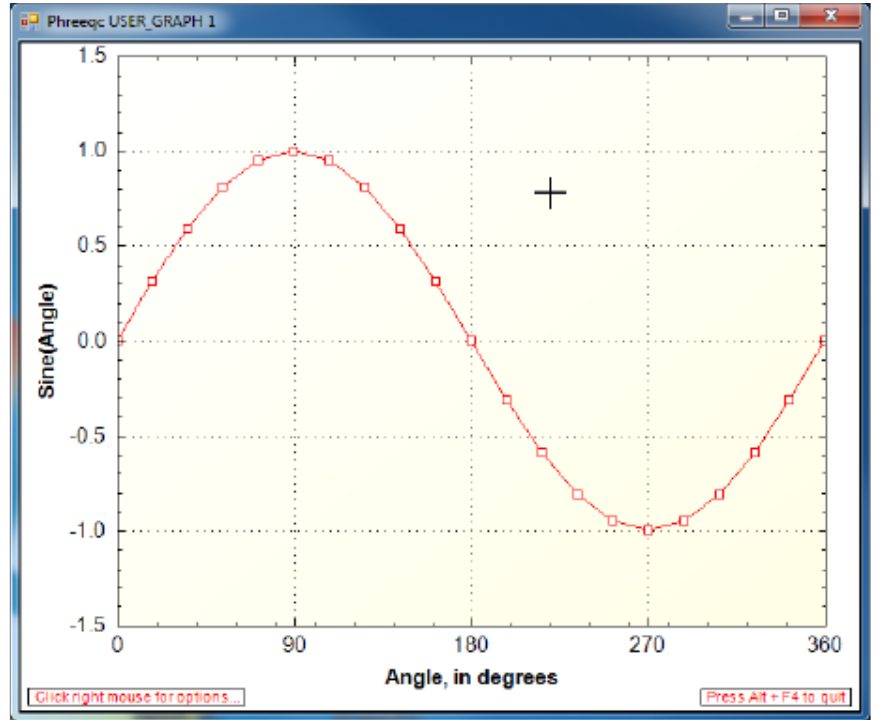
Figure 3. Sine function plotted with a USER_GRAPH data block and exported as a GIF (Graphics Interchange Format)